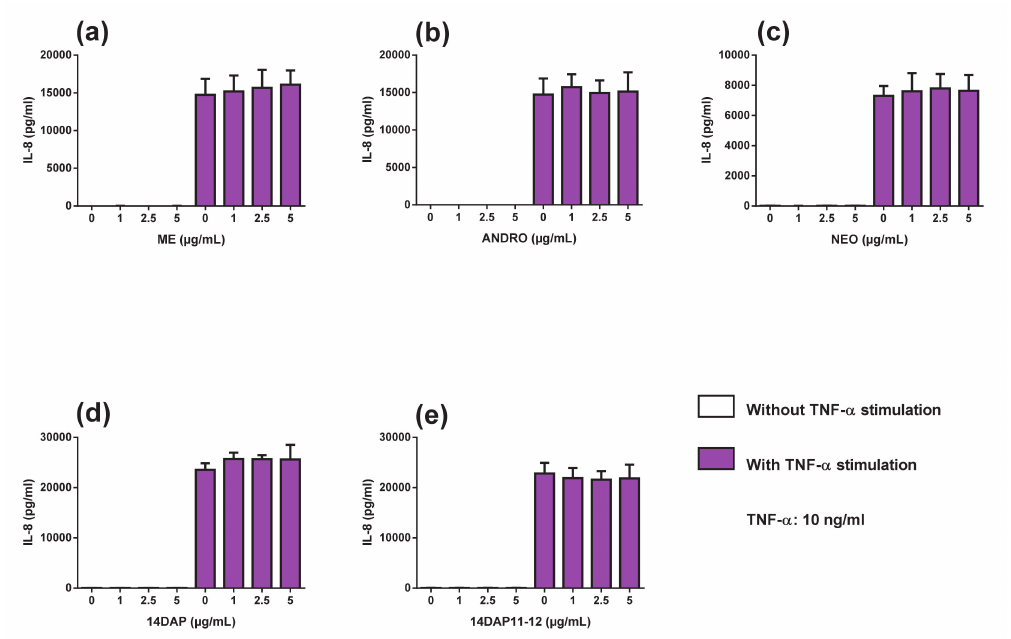
Figure 7. E ff ect of ME, ANDRO, NEO, 14DAP, and 14DAP11-12 on IL-8 secretion. HDFa were treated with increasing concentration (1, 2.5 or 5 µ g / mL) of ME ( a ), ANDRO ( b ), NEO ( c ) 14DAP ( d ), or 14DAP11-12 ( e ) for 24 h. The control cells were treated with 0.05% DMSO. Inflammation was induced by TNF- α (10 ng / mL) and cytokines secretion was done using an ELISA assay. The values mean ± S.D. * p < 0.05 compared with control group, n =